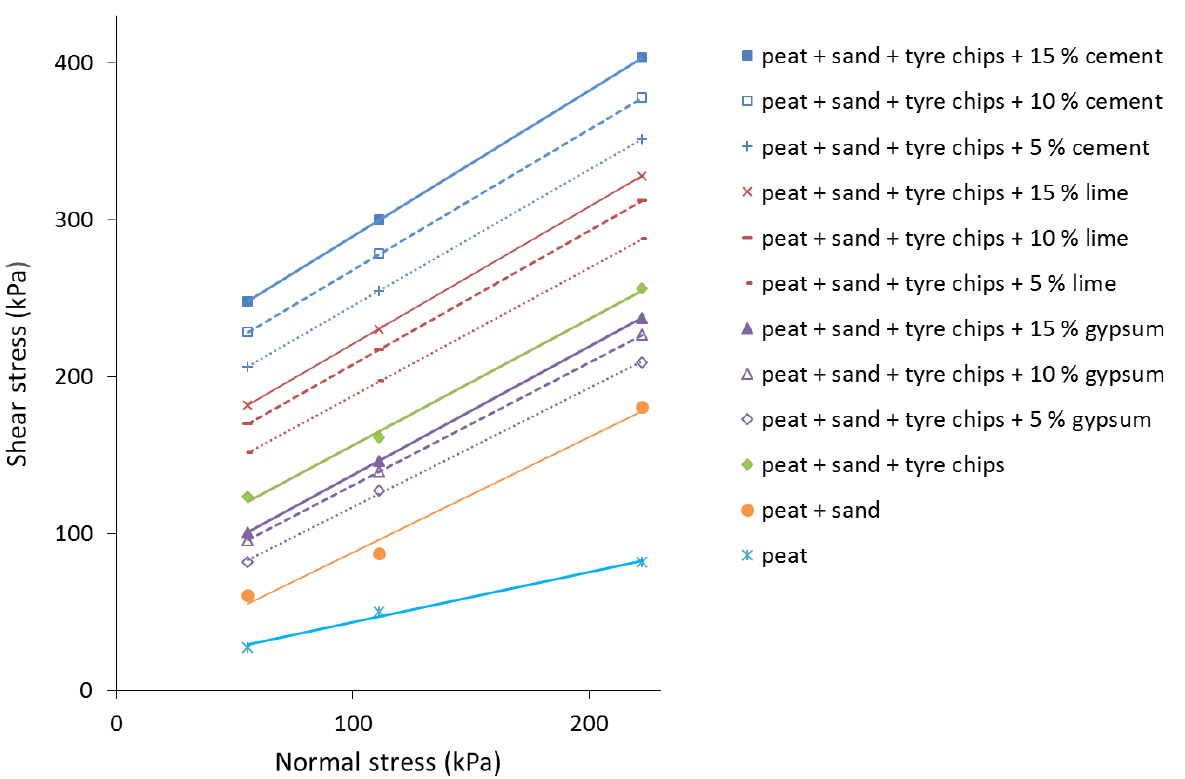
Figure 4. Results of direct shear tests for different soil specimens, with Mohr-Coulomb lines fitted. All sand dosages were 400 kg m -3 and all tyre chip dosages were 10 % by weight. The curing time for all specimens containing gypsum, lime or (ordinary Portland) cement was 28 days. Data for untreated peat, peat with sand, and peat with sand plus tyre chips are taken from Rahgozar & Saberian (2015, 2016). In each case, cohesion (c) is given by the y-intercept and angle of internal friction (φ) by the slope of the